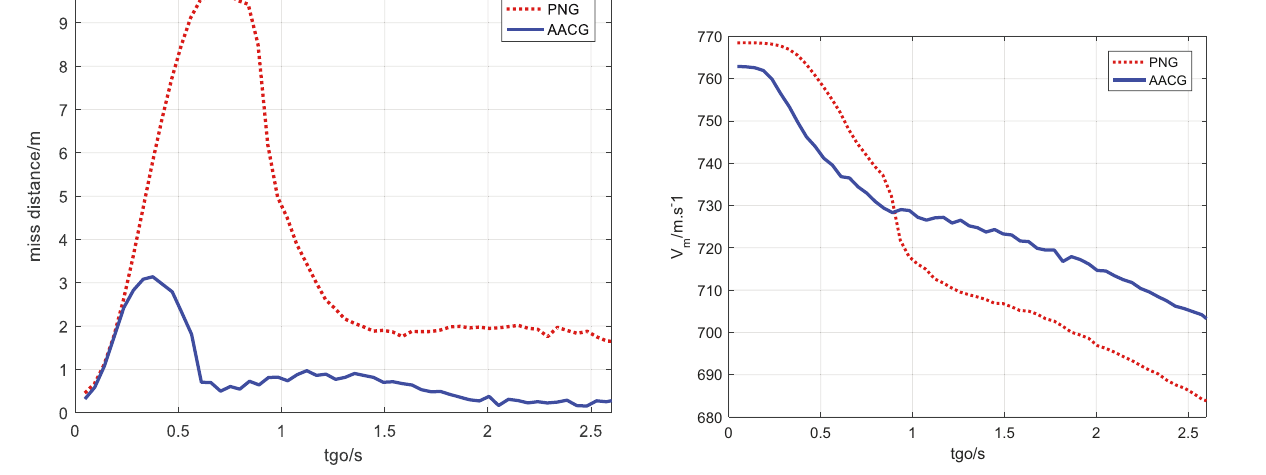
Figure 19: Maneuver beginning t go – miss distance. Figure 20: Maneuver beginning t go – terminal